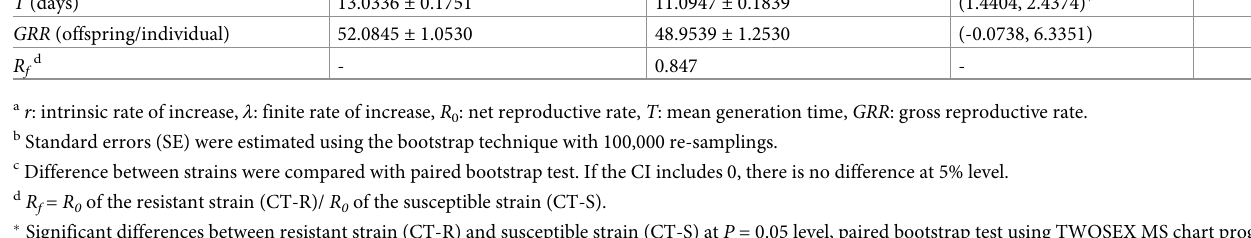
was decreased after 18 th day, which shows lower fecundity as compared to the CT-S strain (Fig 2). In the first 12 days, values of m and l for CT-R strain were higher as compared to m x x x CT-S strain; however, after that, this trend has been reversed, and CT-R strain displayed lower fecundity as compared to the CT-S strain (Fig 2). The e curves in CT-R strain show the xj shorter survival expectancy of the developmental as well as adult stage compared to the CT-S strain of A . gossypii (Fig 3). The v shows the devotion of individuals of age x and stage j xj was recorded lower for the CT-R strain as towards future offspring (Fig 4). The pattern of v xj